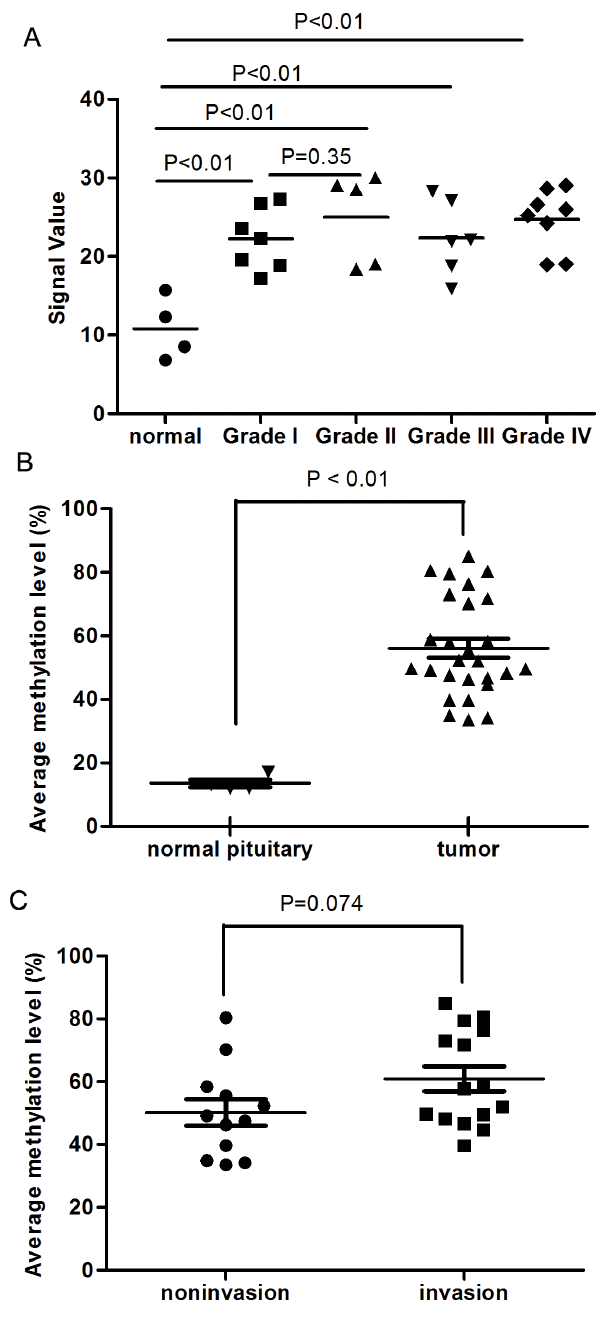
Figure 1. RASSF3 is hypermethylated in pituitary adenomas. (A) Average signal value in RASSF3 promoter of 27 tumors and 4 adenohypophyses. Signal values of the probes were graded from 1 to 32. The average signal values in every grade of tumor were significantly higher than in 4 adenohypophyses. However, there was no significant difference between different tumor grades. (B) Pyrosequencing technology demomstrates that RASSF3 promoter methylation level is higher in human somatotroph adenomas (P , 0.01). The average methylation level of the 10 CpG sites in RASSF3 promoter of the 4 normal samples and 27 tumor samples is shown.